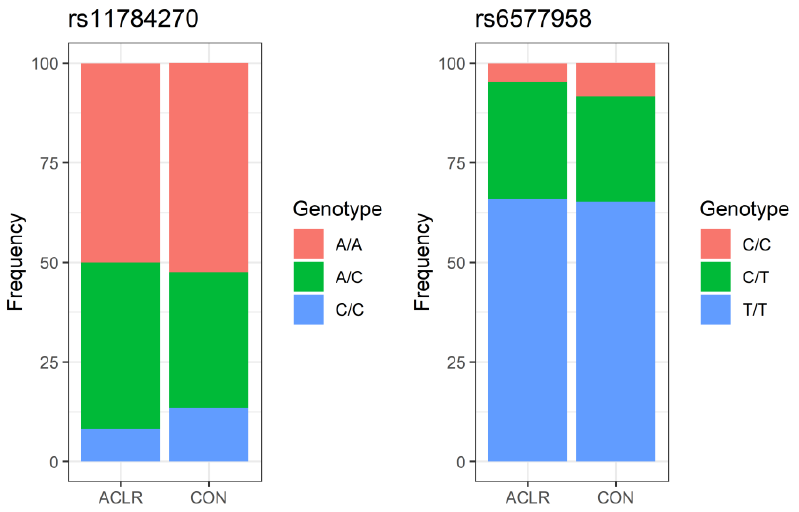
Figure 1. Genotypes frequency in ACLR and control groups.